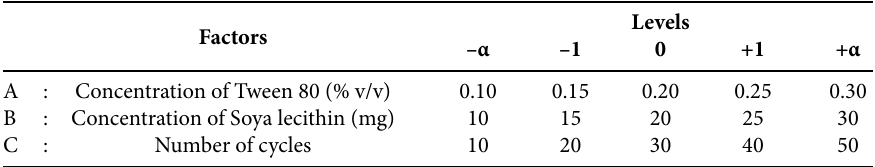
Table 3. 5 3 Central composite designs with independent variables and their